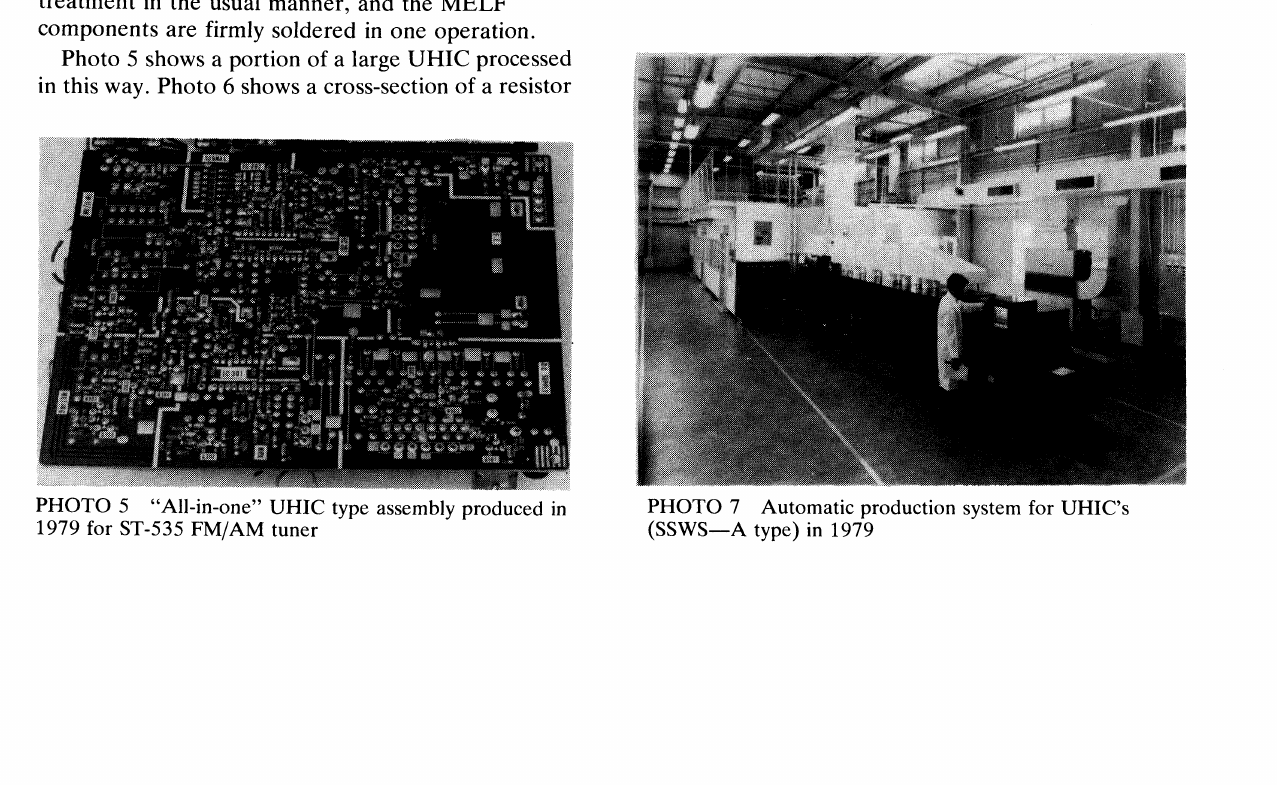
FIGURE 5 Hardened state of the binding resin treatment in the usual manner, and the MELF components are firmly soldered in one